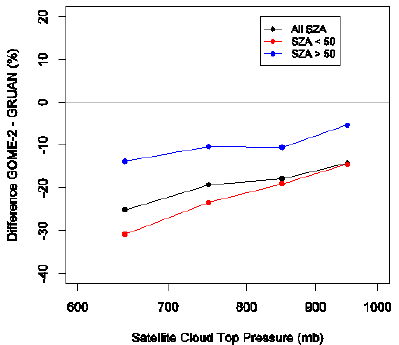
Figure 6. Differences between TWVC data retrieved by GOME-2 and GRUAN sounding data (Eq. 3) as function of satellite cloud top albedo for all cloudy cases (CF > 50%), and those cloudy cases with satellite SZA < 50 ◦ , and SZA > 50 ◦ .